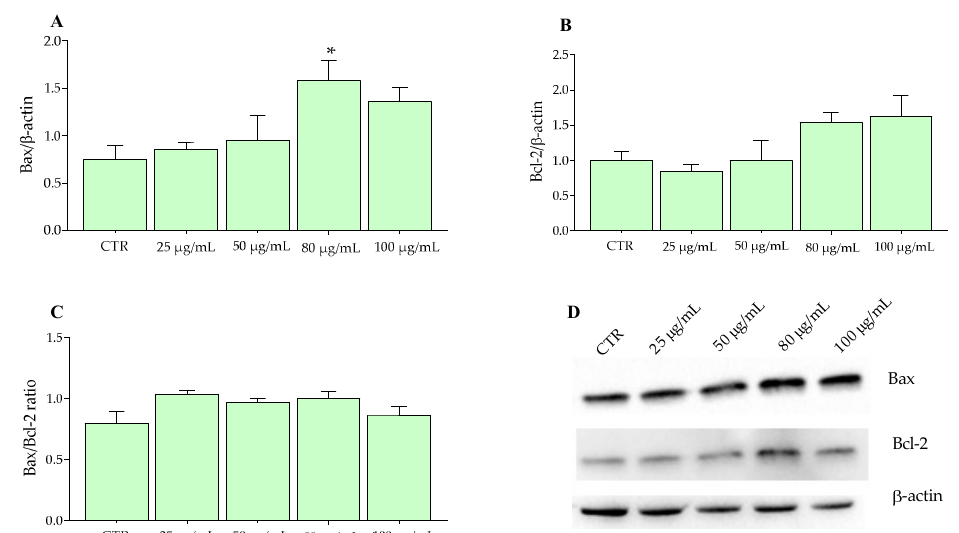
Figure 6. Western blotting analysis of proteins in SW480 cells exposed to Aglianico GP gastrointes- tinal digested extract at increasing concentrations for 24 h. ( A ) Bax proteins; ( B ) Bcl-2 proteins; ( C ) Bax/Bcl-2 ratio; ( D ) Relative blots. All data represent the results of three different experiments (means ± SD). p -value was determined by ANOVA with Dunnett’s test. * p < 0.01. Although the two cell lines belong to colorectal cancer lines, they differ in both mor- phology and degree of differentiation (i.e., HT29 is more differentiated than SW480) [42–